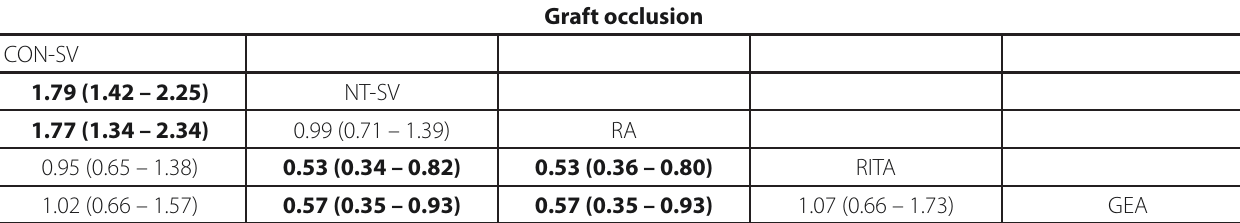
Table 3. League tables summarizing the results of the network meta-analysis (expressed as incidence rate ratio with 95% confidence interval) for graft occlusion using random effects